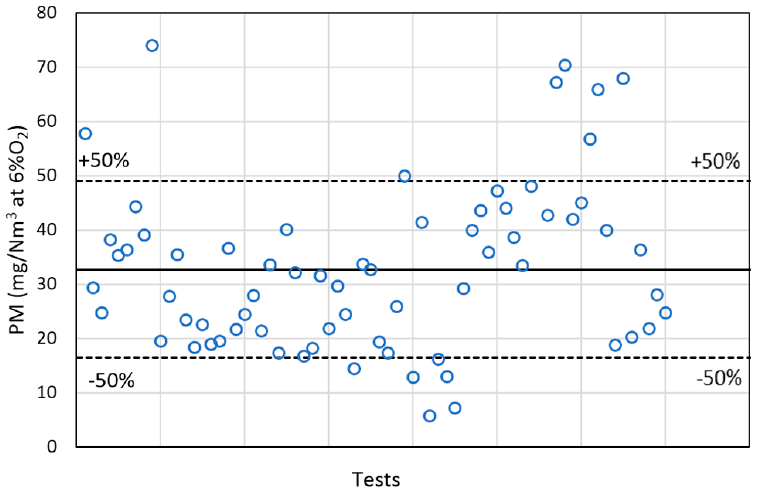
Figure 11. Complete set of PM measurements for different fuels and air configurations using the Dekati low-pressure cascade impactor (DLPI).